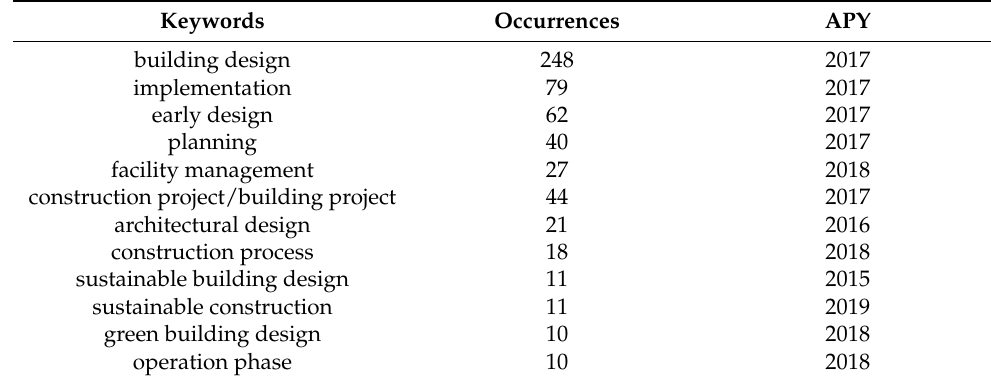
Table 3. Stages of a building’s life cycle as analyzed in papers on BIM and building energy